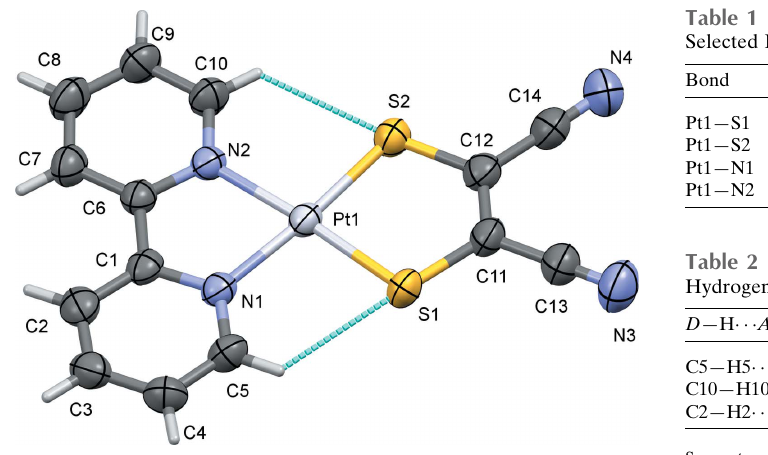
Figure 1 A view of the molecular structure of the title compound, with atom labeling. Displacement ellipsoids are drawn at the 50% probability level. The short intramolecular C—H (cid:2)(cid:2)(cid:2) S contacts are shown as dashed lines (Table